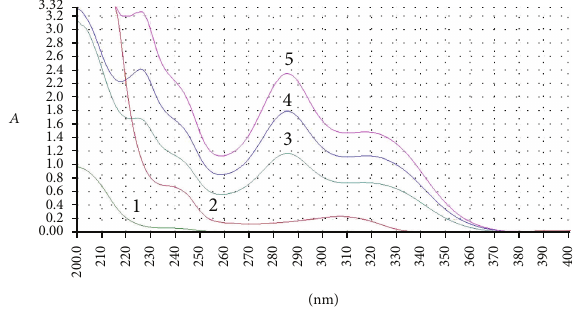
Figure 3: Selected UV spectra of shampoo solutions and BZ4 standards in pH 6 phosphate buffer-water 1:20 (v/v). 1: shampoo matrix (2.5 mgmL −1 , 0% BZ4); 2: shampoo matrix (20mg mL −1 , 0% BZ4); 3: shampoo (2.5 mg mL −1 , 1.0% BZ4); 4: BZ4 standard (0.04 mgmL −1 ); 5: shampoo (2.5 mgmL −1 , 2.0% BZ4).